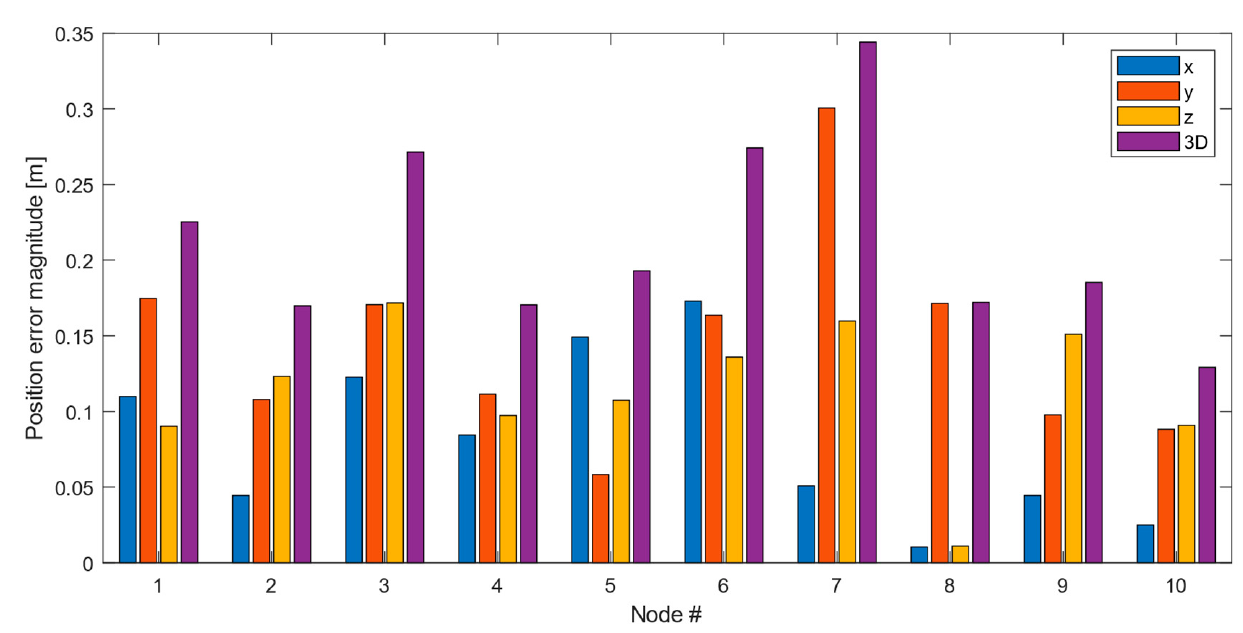
Figure 16. Position errors following MDS/SMACOF reconstruction.